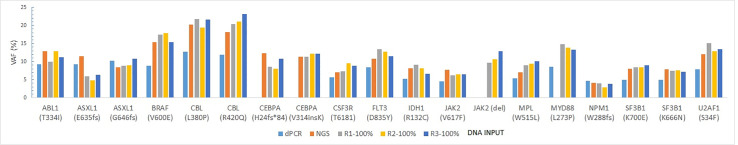
Intra-run performance using Seraseq Myeloid Mutation DNA run in triplicate.